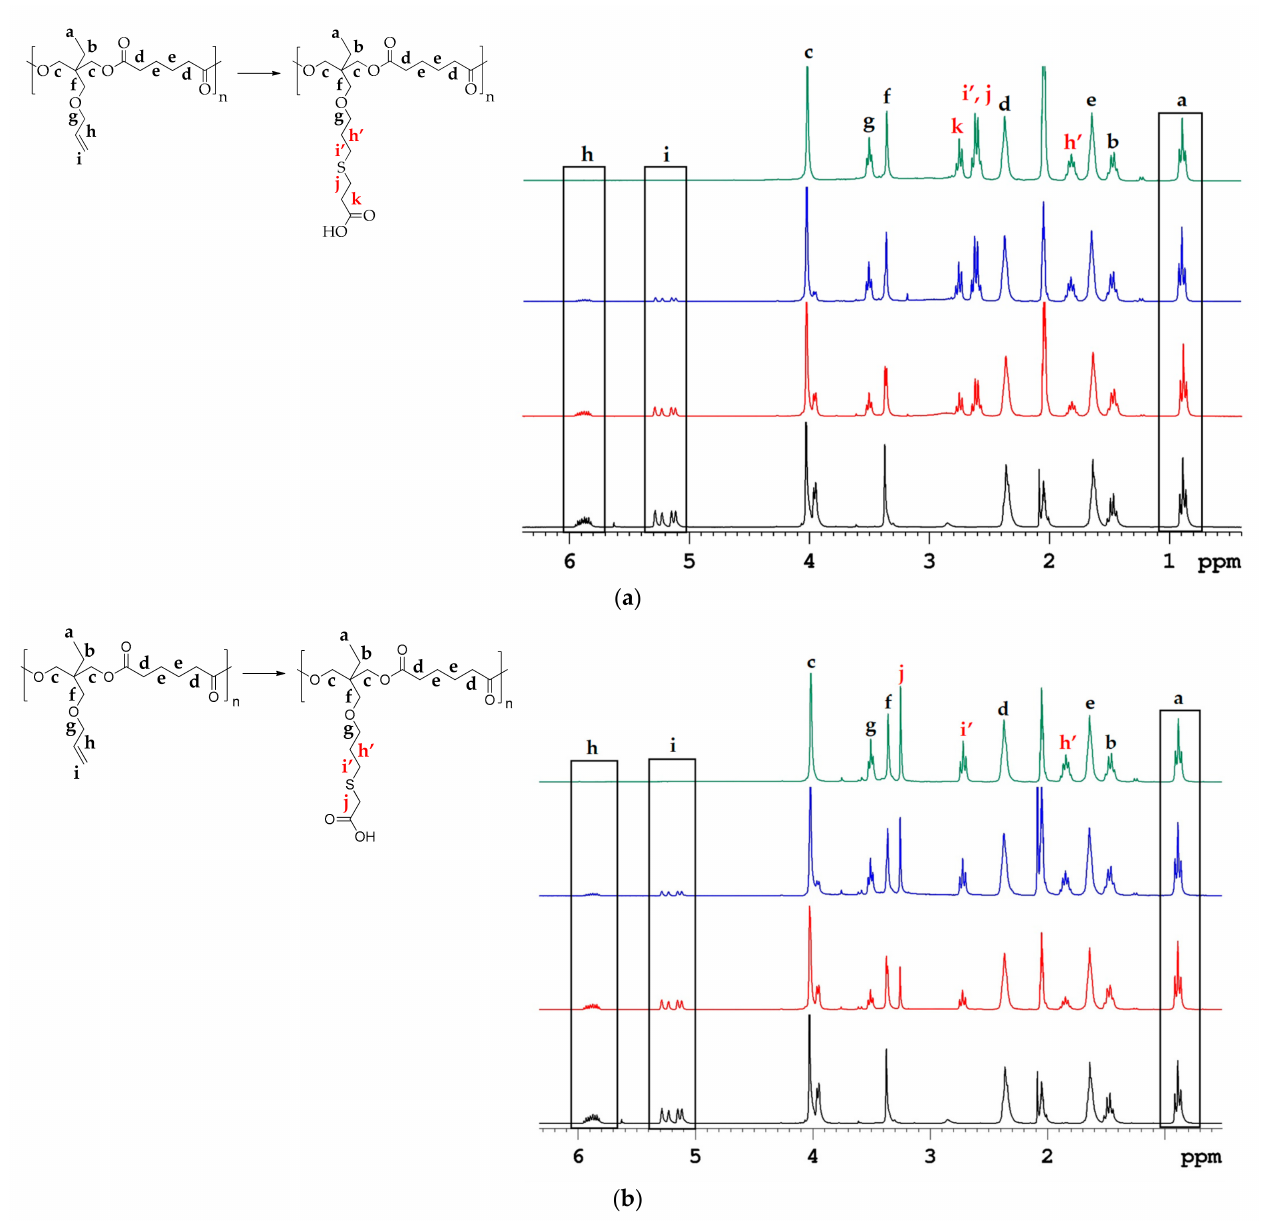
Figure 2. 1 H NMR spectra of ( a ) P(TPAE- alt -AD) (black line), PE-Prop50 (red line), PE-Prop80 (blue line), and PE-Prop100 (green line) and ( b ) P(TPAE- alt -AD) (black line), PE-Glyc50 (red line), PE-Glyc80 (blue line), and PE-Glyc100 (green line), in d6-acetone, where the peaks labeled (a–k) correspond to the protons of the repeat units of the polyester shown on the